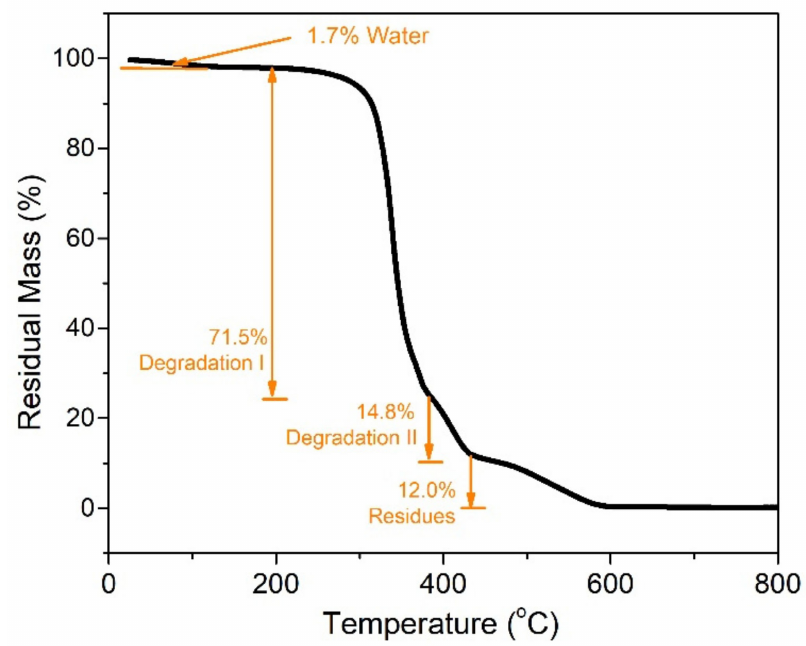
Figure 4. TGA curve for the gel obtained by curing of a stoichiometric blend of PEGDE and ED600 for 24 h at 80 ◦